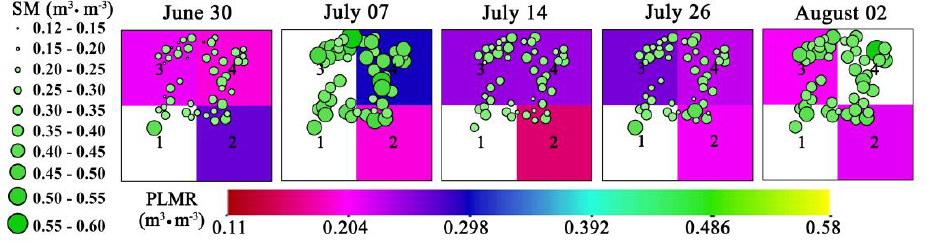
Figure 2. SoilNET soil moisture (SM) except deleted outliers and PLMR products (white color means no data).